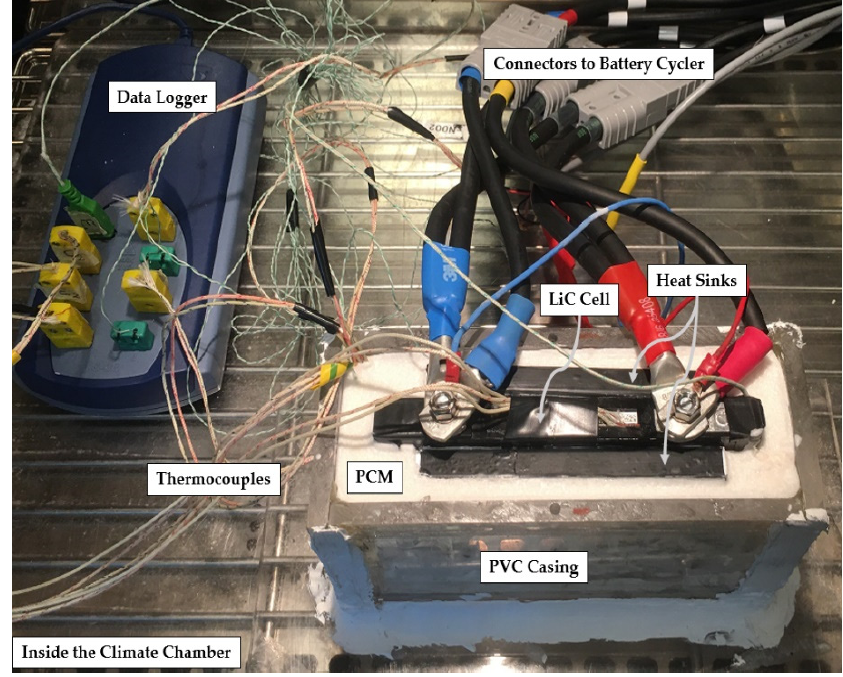
Figure 14. The experimental test bench of the hybrid PCM-heat sink passive-passive TMS [41].